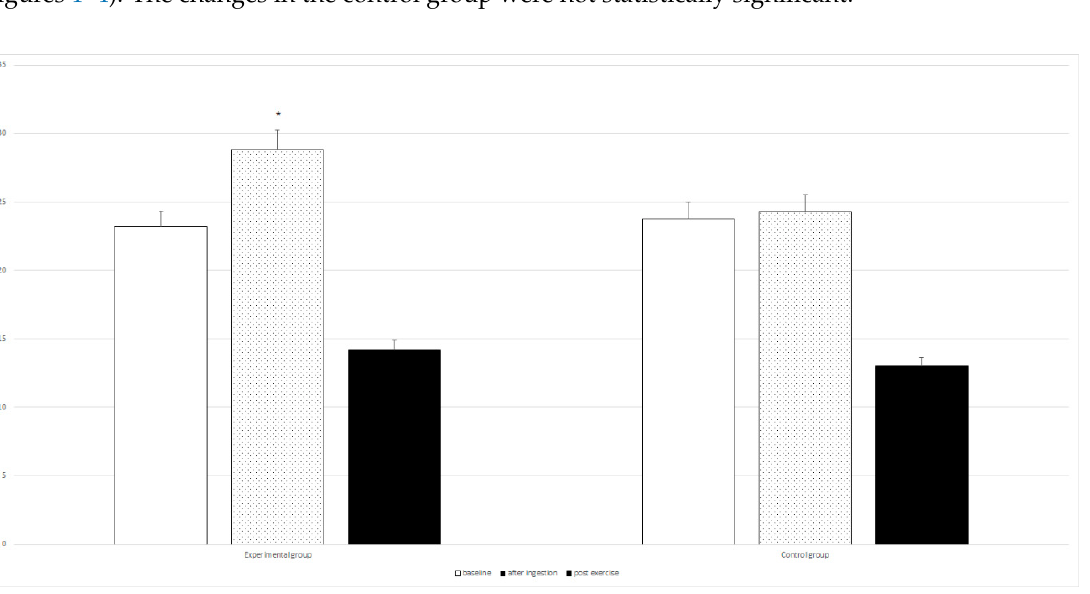
Figure 1. Differences between baseline and post-intervention period in the RAST (6 × 30 m) results for the experimental and control groups. * statistically significant; in experimental group RI = 2.23% (the result improving); in control group RI = 1%.